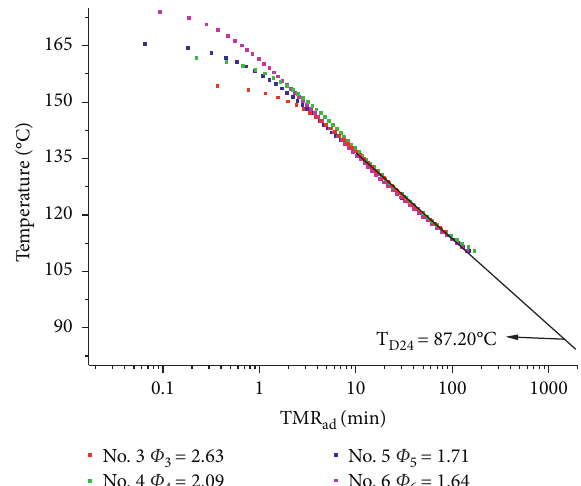
Figure 8: The relationship curve between corrected solution temperature and TMR ad for 40%